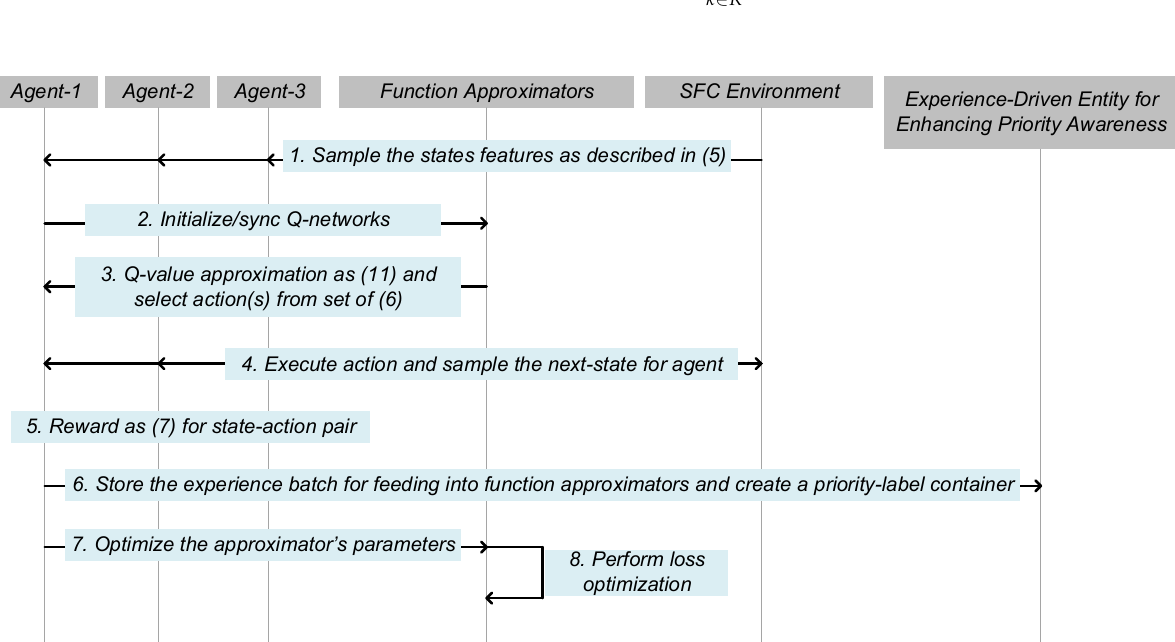
Figure 4. State transition procedure between each agent, function approximators, SFC environment, and experience-driven entities for enhancing priority awareness.